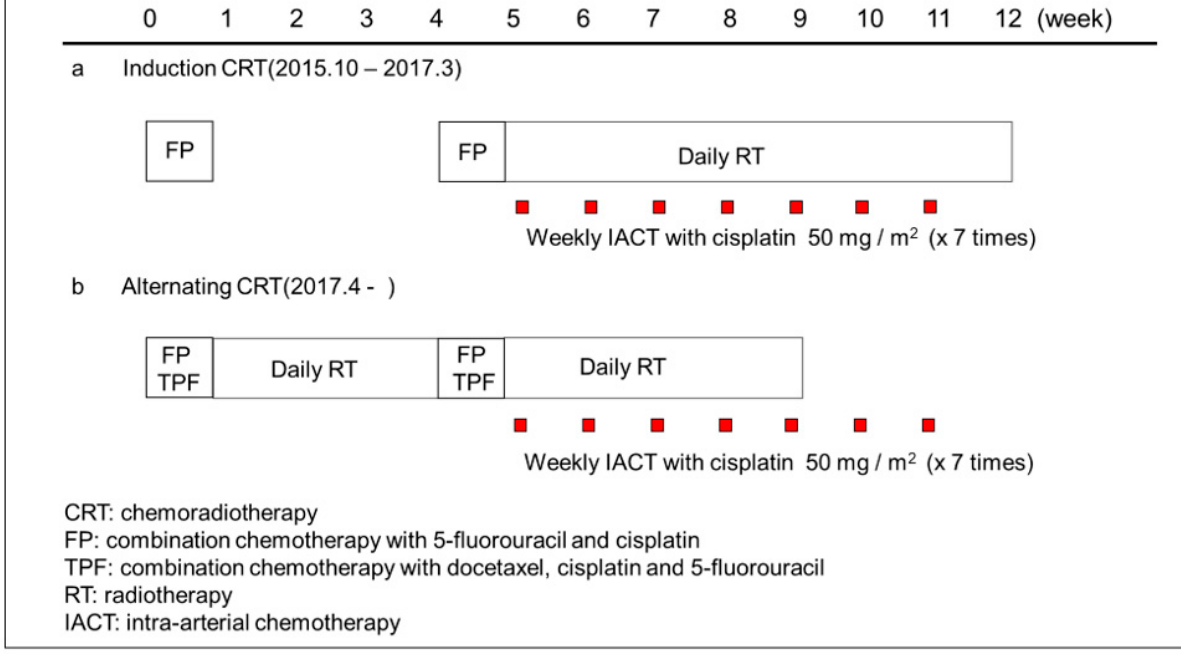
Figure 1. Treatment scheme. ( a ) Until March 2017, patients received two courses of induction chemotherapy (cisplatin and fluorouracil [FP]), followed by daily radiotherapy (RT) combined with weekly intra-arterial chemotherapy (IACT). ( b ) From April 2017, patients first received alternating chemoradiotherapy, which comprised two courses of chemotherapy (regimen FP or docetaxel, cisplatin, and fluorouracil [TPF]) and daily RT followed by concurrent RT with weekly IACT.